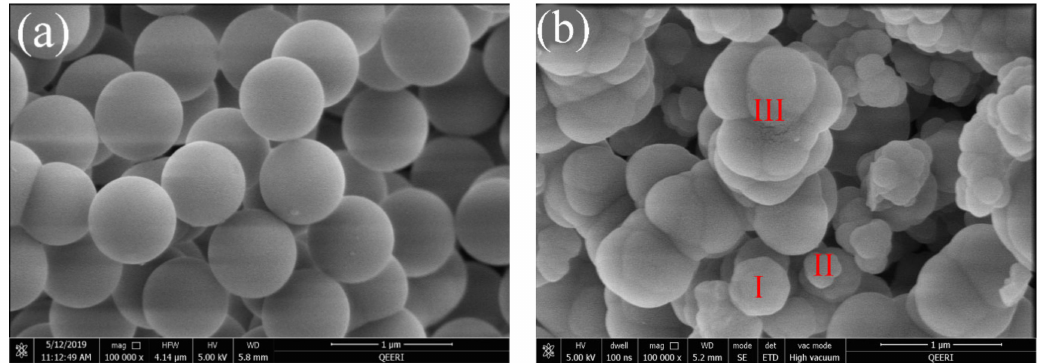
Figure 7. Micrographs of ( a ) well-defined and ( b ) fused particles (13 and 3, respectively, as shown in Table 2 and Figure 6).